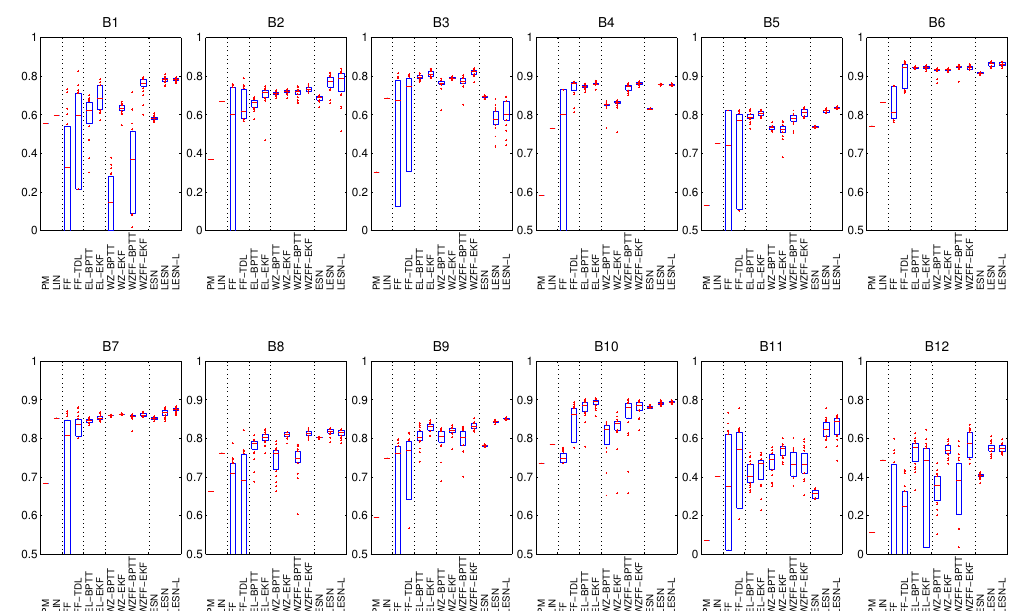
Fig. 5. Test performance in terms of CE. The box plot expresses statistics of over 20 models runs. The central mark is the median, the edges of the box are the first and third quartiles, and points outside that range are plotted individually as dots. Note that not all subfigures have the same scale.